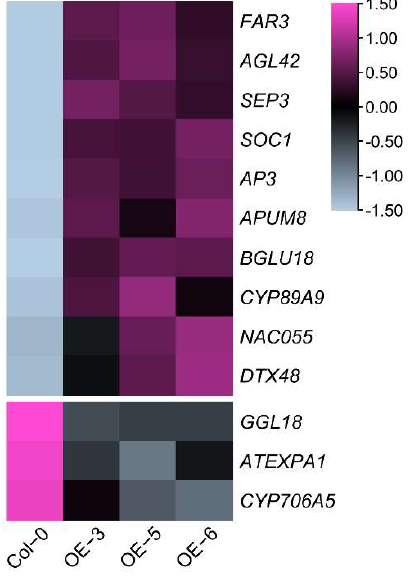
Figure 9. Expression patterns of Arabidopsis AtFLC target genes [33] in WT and OE-CsFLC1 trans- genic Arabidopsis thaliana . The pink color represents upregulated genes, the blue color represents downregulated genes, and the heatmap was generated by TBtools.